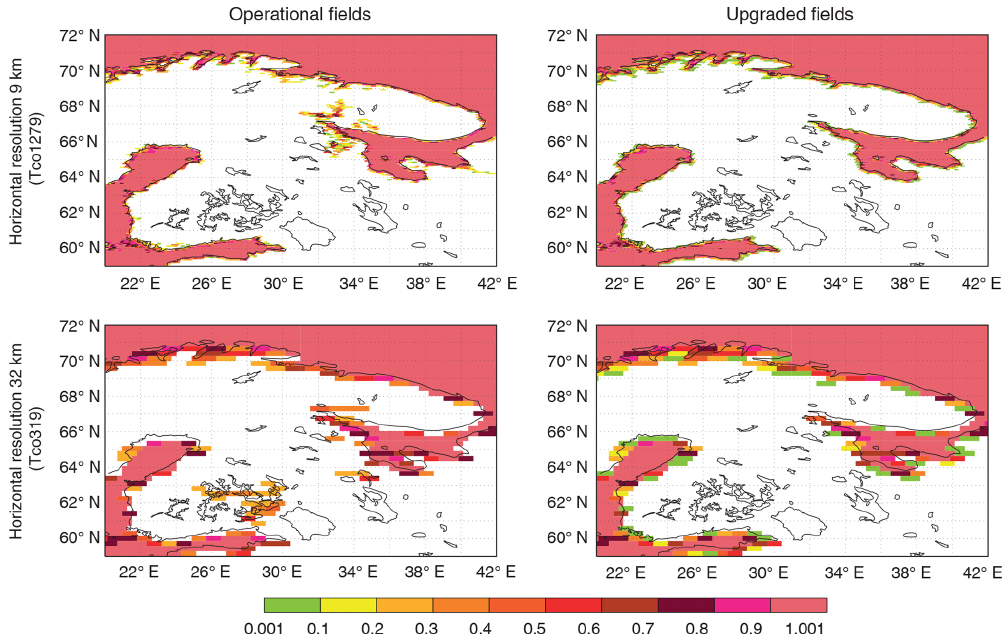
Figure 1. Combination of operational and upgraded Fr land and Fr lake fields showing the remaining ocean water over Finland and north- western Russia (59–72 ◦ N, 20–42 ◦ E) at different horizontal resolutions; colours indicate the ocean fraction in each grid box: white – no ocean; pink – fully covered with ocean.